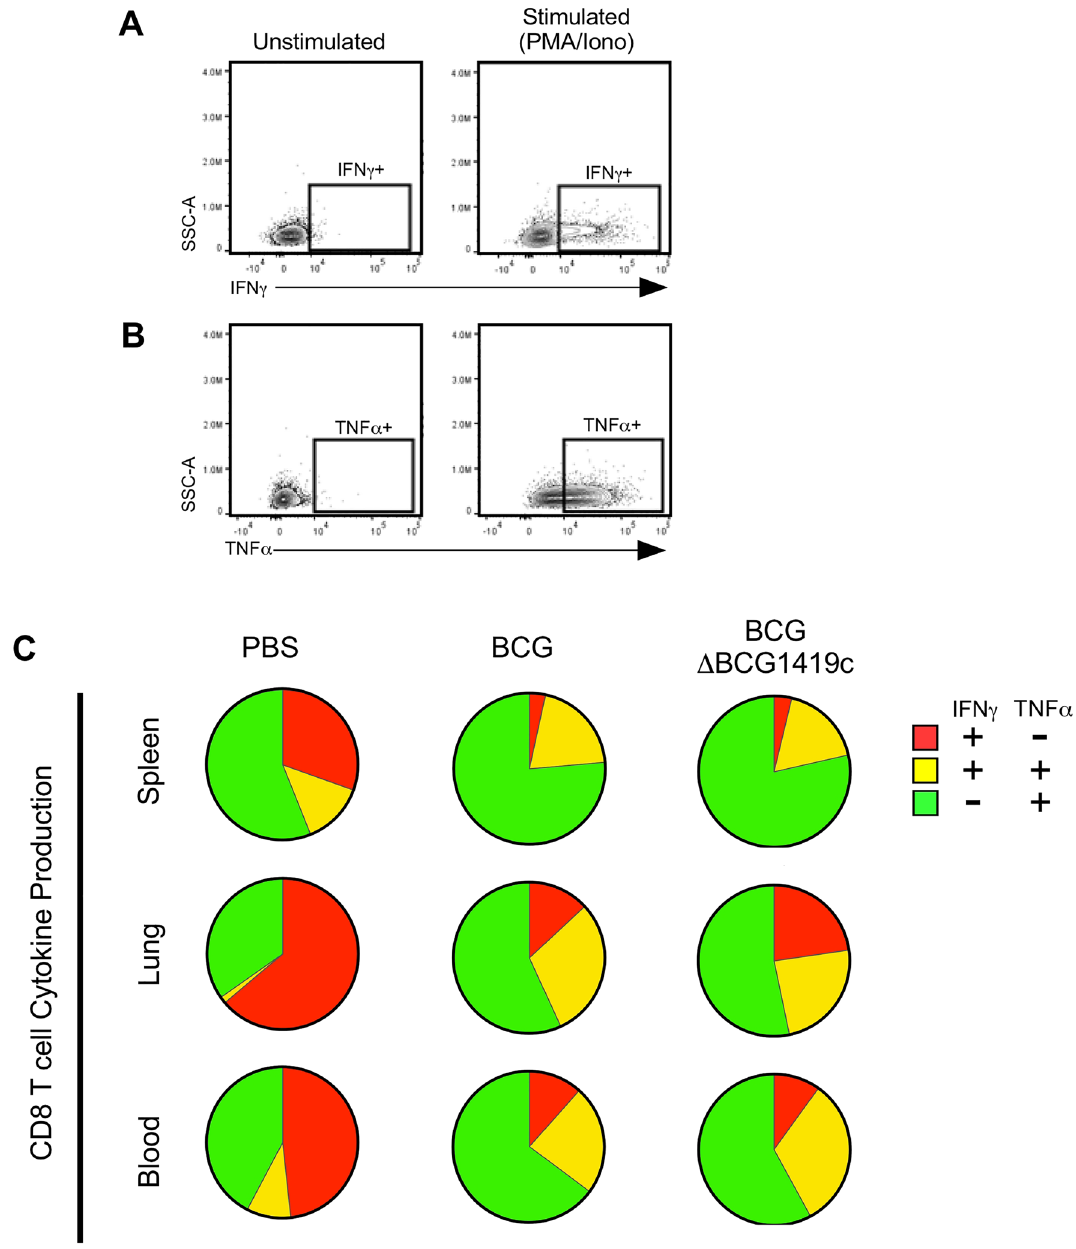
Figure 9. CD8 T cell cytokine production in BCG- and BCGΔBCG1419c-immunized mice. C57BL/6 mice were s.c. immunized with 10 4 CFU of either BCG or BCGΔBCG1419c, or PBS as a control; 18 days later, mononuclear cells from the spleen, lung and blood were prepared and used for intracellular cytokine staining, following stimulation with PMA/Ionomycin. Shown are ( A ) representative IFNγ staining and ( B ) representative TNFα staining of unstimulated and stimulated mononuclear cells, gated off CD8 T cells; ( C ) Spice analysis of single positive (IFNγ + and TNFα + ) and double positive (IFNγ + TNFα + ) CD8 T cells in the spleen, lung and